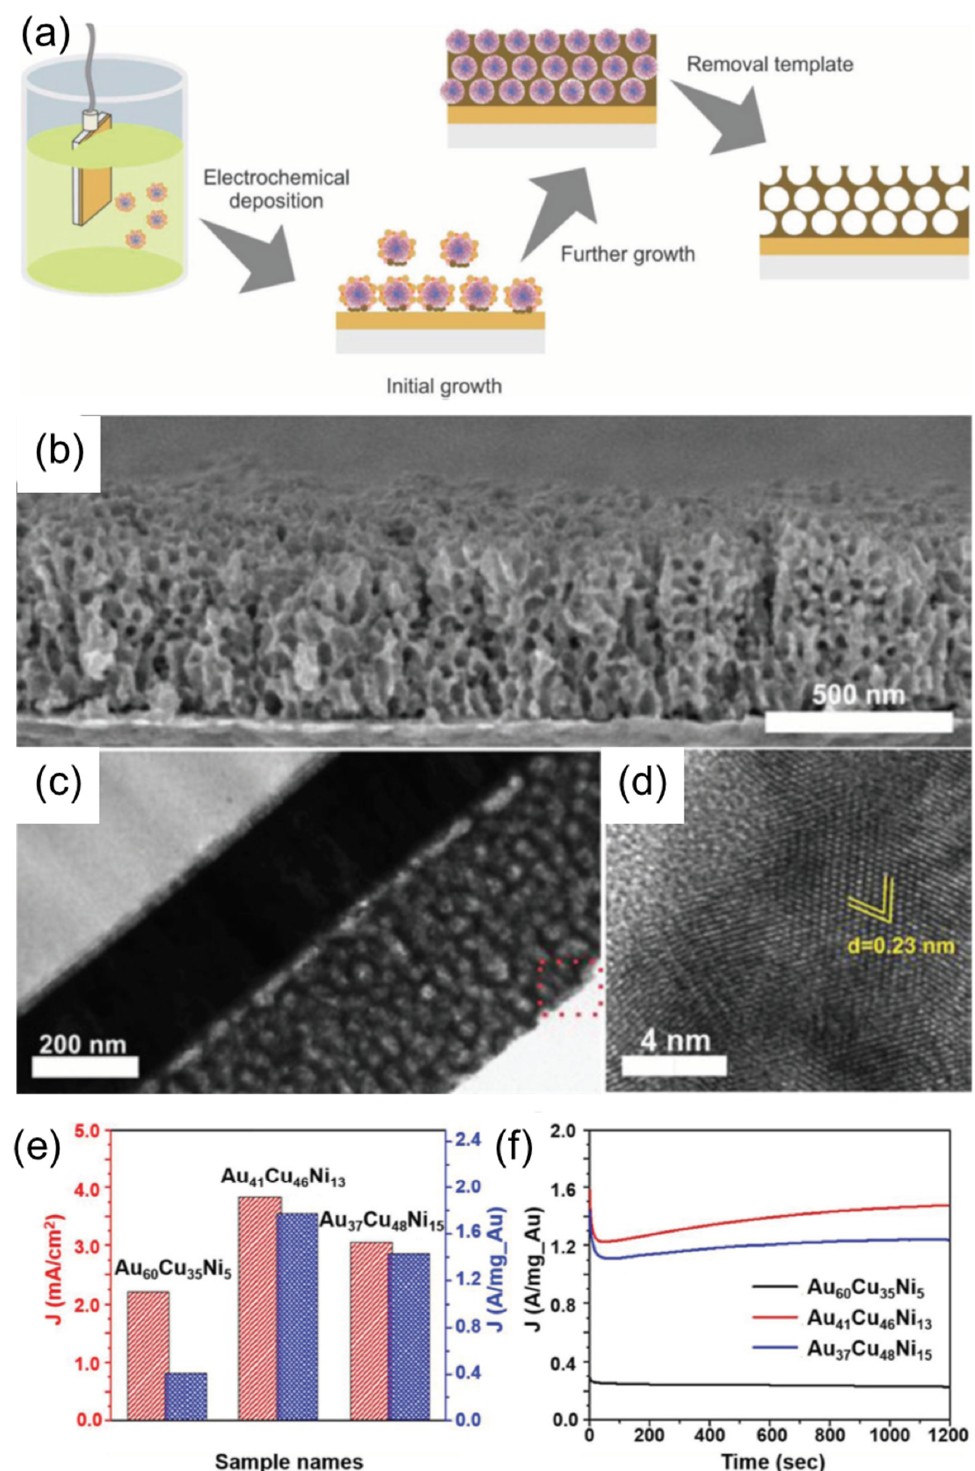
Figure 10. ( a ) Schematic illustration of the electrochemical synthesis of mesoporous, AuCuNi ternary alloy film. ( b ) Cross-sectional SEM image, ( c ) TEM image, and ( d ) high-resolution of TEM image of the mesoporous Au 60 Cu 35 Ni 5 film obtained at an applied electrodeposition potential of − 0.9 V (vs Ag/AgCl) at 40 °C for 1000 s. ( e ) Electrocatalytic activity and ( f ) amperometric response of the mesoporous AuCuNi ternary alloy films with different compositions, recorded at an applied potential of 0.65 V for 1200 s in 1 M NaOH solution + 0.5 M CH 3 OH. Adapted from